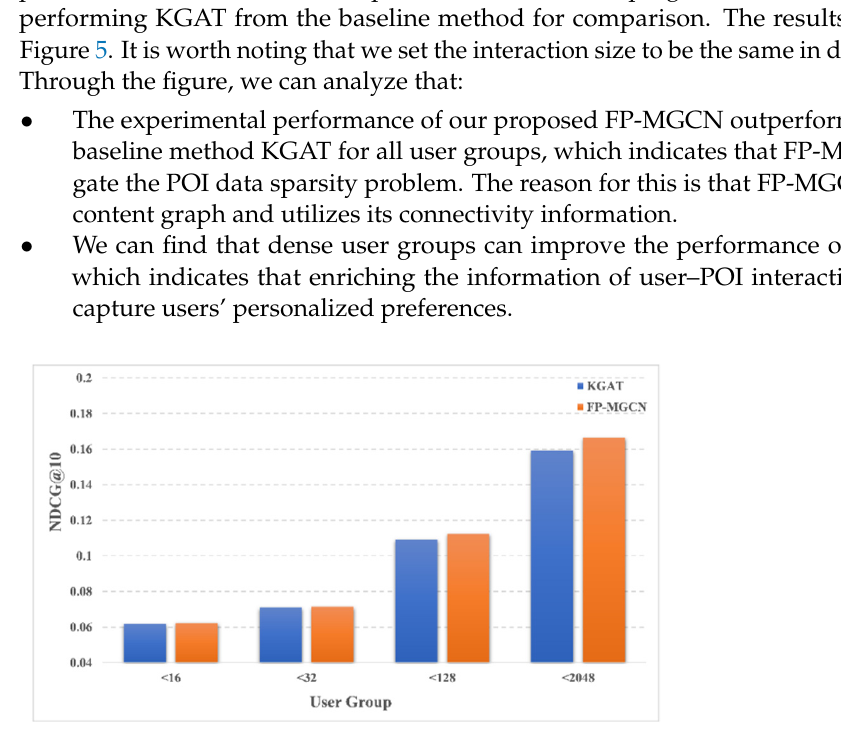
Figure 5. The performance of the model in different sparsity distributions of user groups.